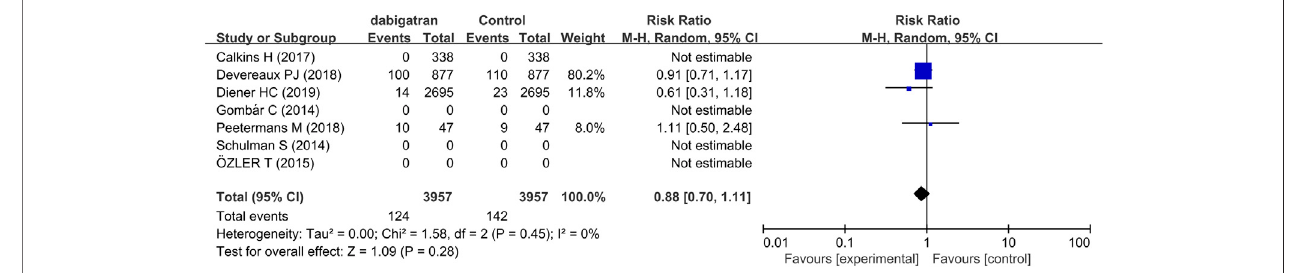
FIGURE 8 | Forest plot comparing the RR of all-cause mortality between the experimental (dabigatran) and control groups.